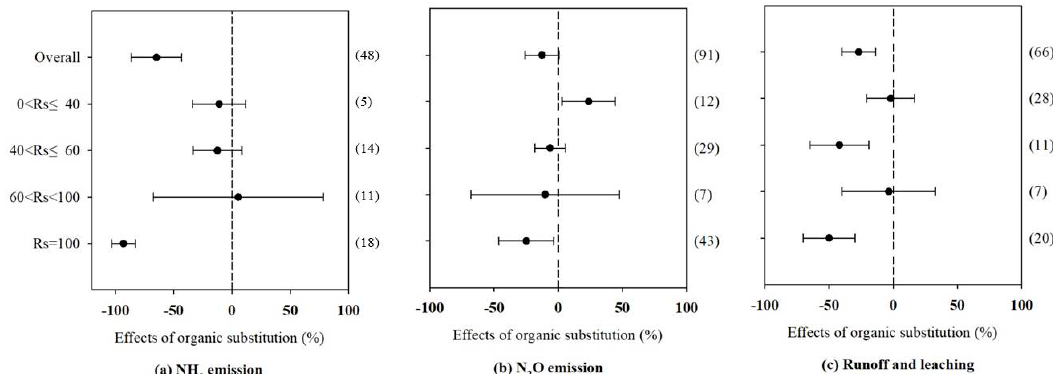
Figure 6. Effects of organic fertilizer substitution on NH 3 emissions ( a ), N 2 O emissions ( b ), and runoff and leaching ( c ) under four substitution rates. Rs, substitution rate, defined as organic nitrogen (N) input/total N applied (%). Error bars represent 95% confidence intervals. Numbers in parentheses indicate the numbers of observations.